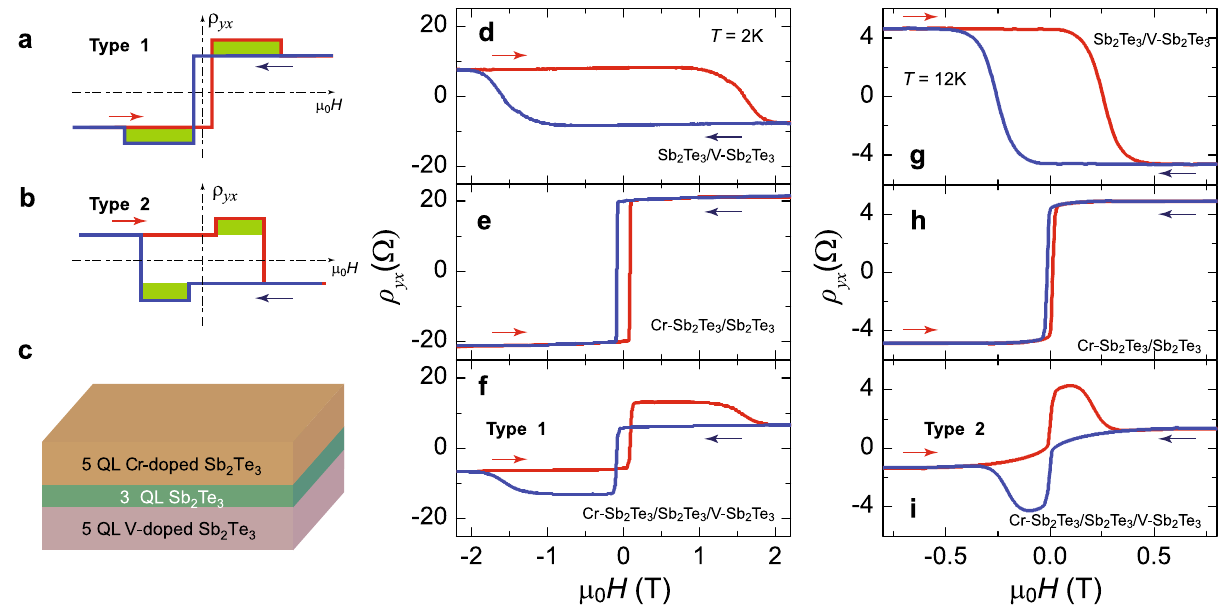
Fig. 5 The arti fi cial “ TH effect ” in magnetic TI/TI/magnetic TI sandwich heterostructures. a , b Two types of arti fi cial “ TH effect ” formed by the parallel connection of two AH effects with opposite signs. Type 1 is constructed by the AH effect with the larger coercive fi eld ( μ 0 H c ) showing smaller ρ yx , while Type 2 is constructed by the AH effect with the larger μ 0 H c showing larger ρ yx . c Schematic for the 5 QL Cr-doped Sb 2 Te 3 /3 QL Sb 2 Te 3 /5 QL V-doped Sb 2 Te 3 sandwich sample. d , g μ 0 H dependence of ρ yx of the 3 QL Sb 2 Te 3 /5 QL Sb 1.92 V 0.08 Te 3 bilayer heterostructure measured at T = 2 K ( d ) and T = 12 K ( g ). e , h μ 0 H dependence of ρ yx of the 5 QL Sb 1.84 Cr 0.16 Te 3 /3 QL Sb 2 Te 3 bilayer heterostructure measured at T = 2 K ( e ) and T = 12 K ( h ). f , i μ 0 H arrows indicate the magnetic fi eld sweep